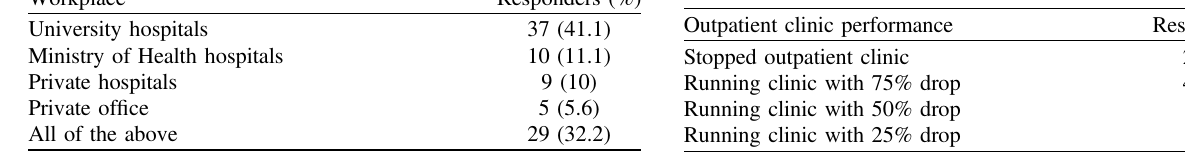
Table 3. Effect of COVID-19 on outpatient clinics of spine